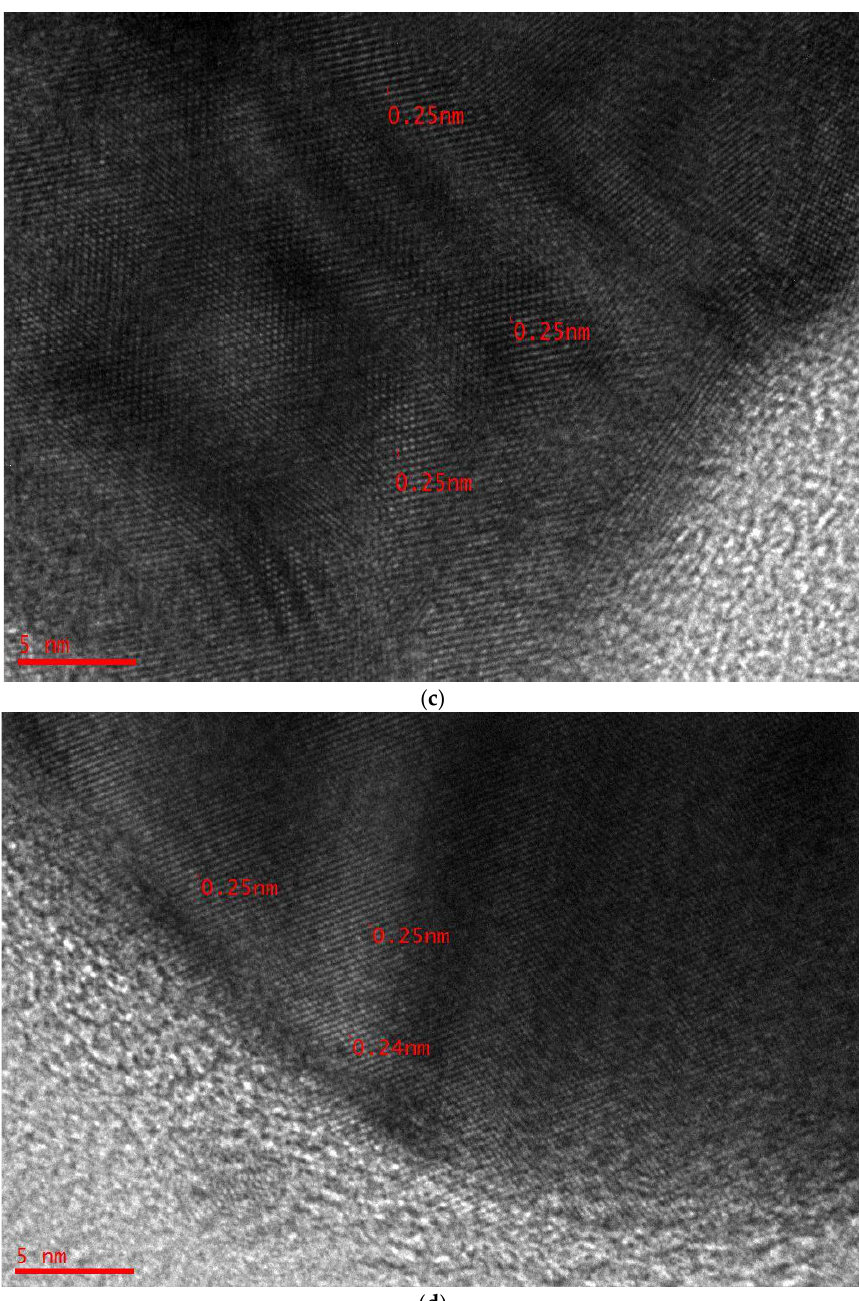
Figure 7. ( a ) TEM micrographs displaying spherical Ag NPs of 100 nm. ( b ) TEM micrographs displaying spherical Ag NPs of 50 nm. ( c ) HR-TEM image displaying IPDs of 0.25 nm. ( d ) HR-TEM image displaying IPDs of 0.24 nm.